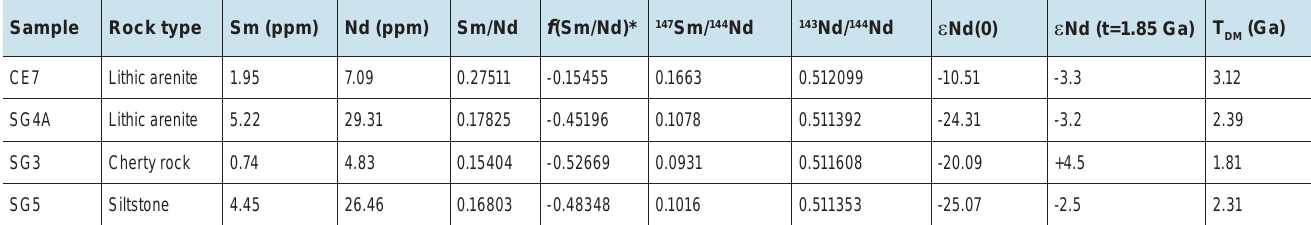
Table 4 - Whole rock Sm-Nd data